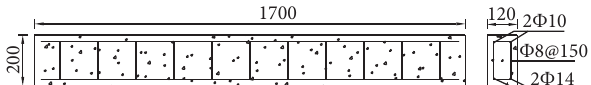
Figure 6: Size and reinforcement diagram of experimental beams (mm).